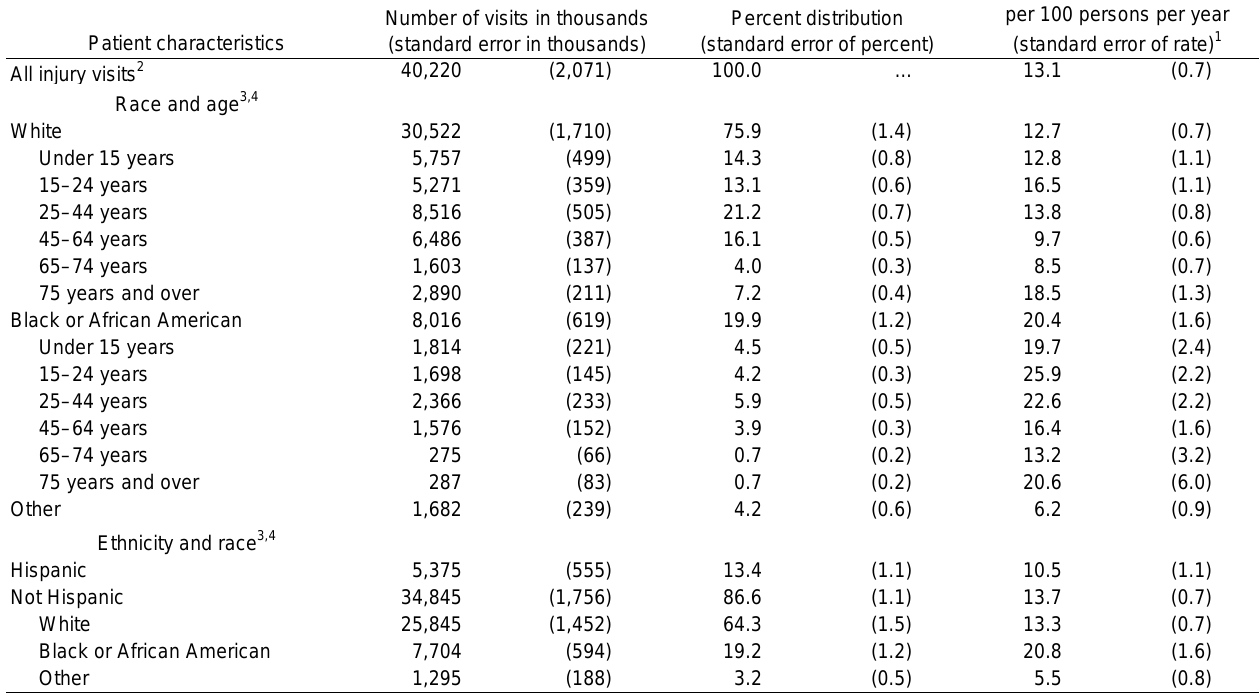
Table 15. Injury visits to emergency departments by race and age, and ethnicity: United States, 2011